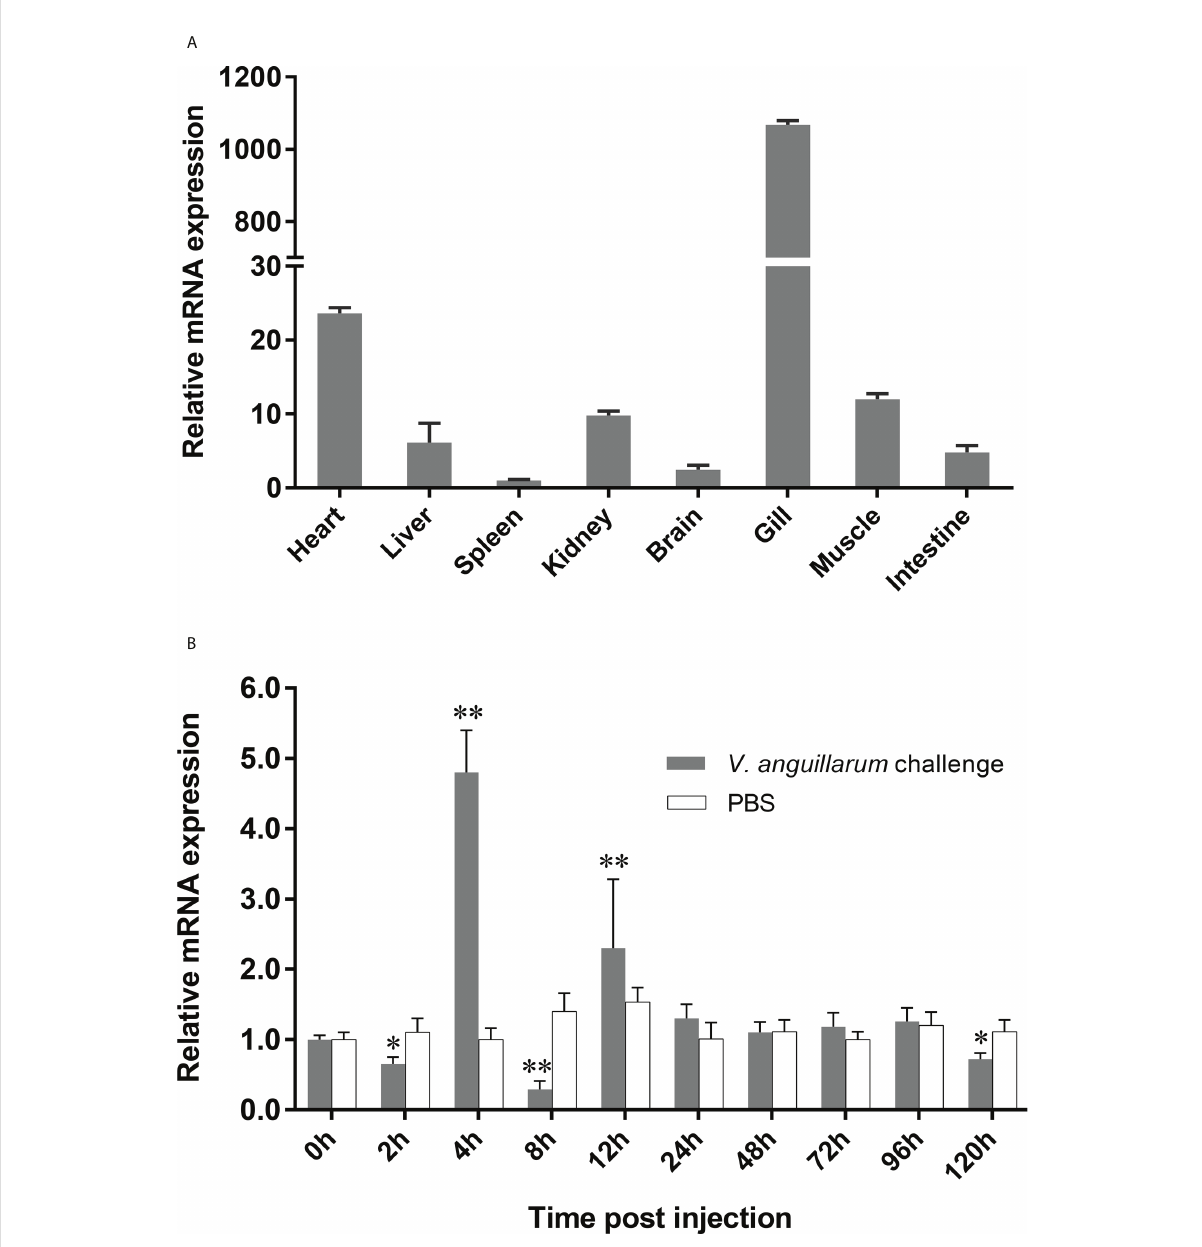
FIGURE 2 Expression pro fi les of OppLTL in normal tissues and when challenged with V. anguillarum . (A) Tissue distribution of the OppLTL expression level. (B) OppLTL expression in response to the V. anguillarum challenge in gill. Data are shown as mean ± SD ( n = 3). Signi fi cant difference (* P < 0.05 and ** P < 0.01) between V. anguillarum -challenged tissues and blank control (at 0 h) is indicated with an